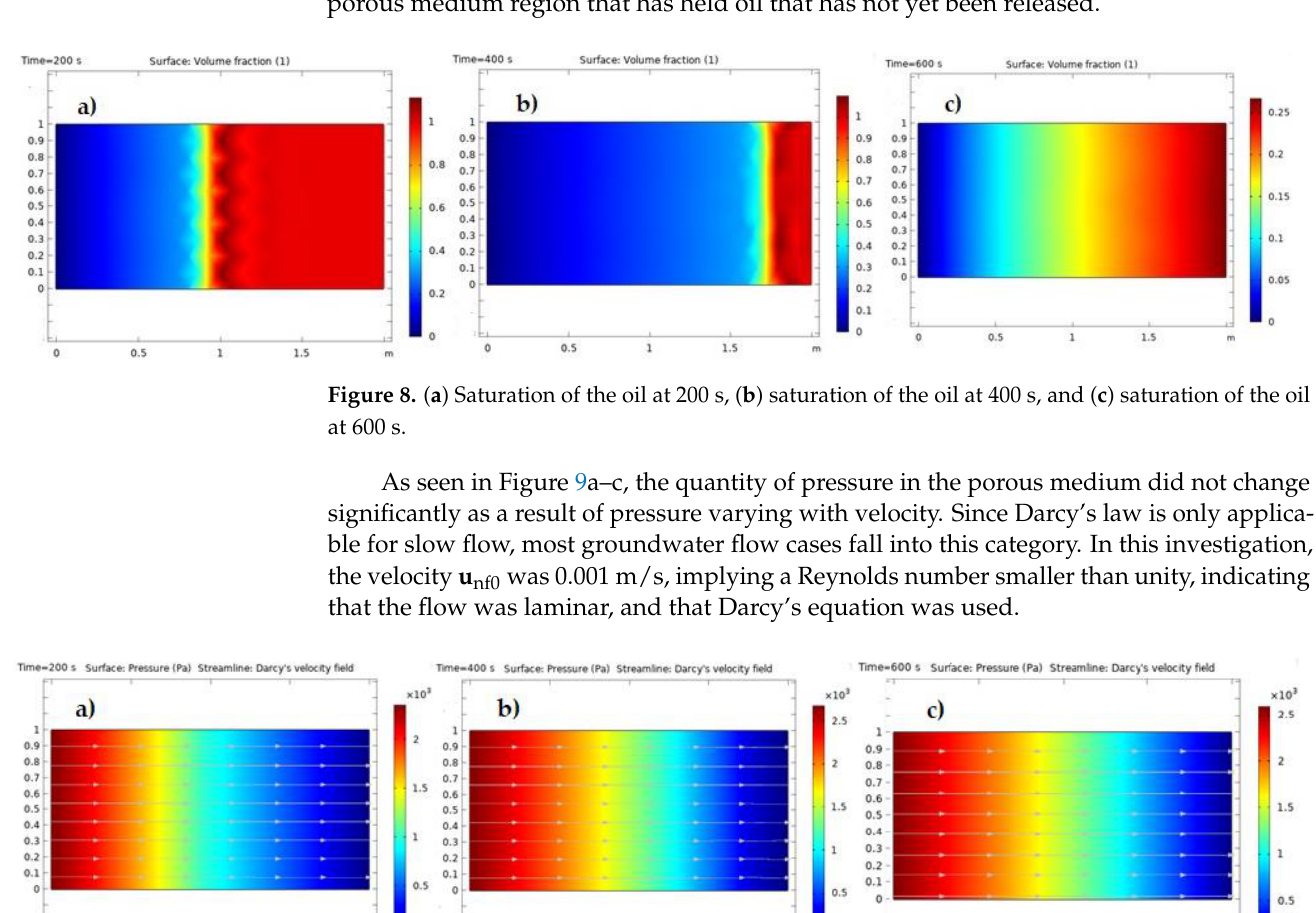
Figure 9. ( a ) Pressure distribution inside the porous medium at 200 s, ( b ) pressure distribution inside the porous medium at 400 s, and ( c ) pressure distribution inside the porous medium at 600 s.